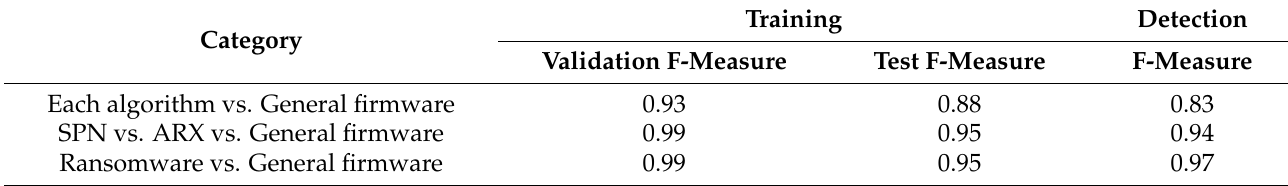
Table 8. Evaluation of the pruned model.